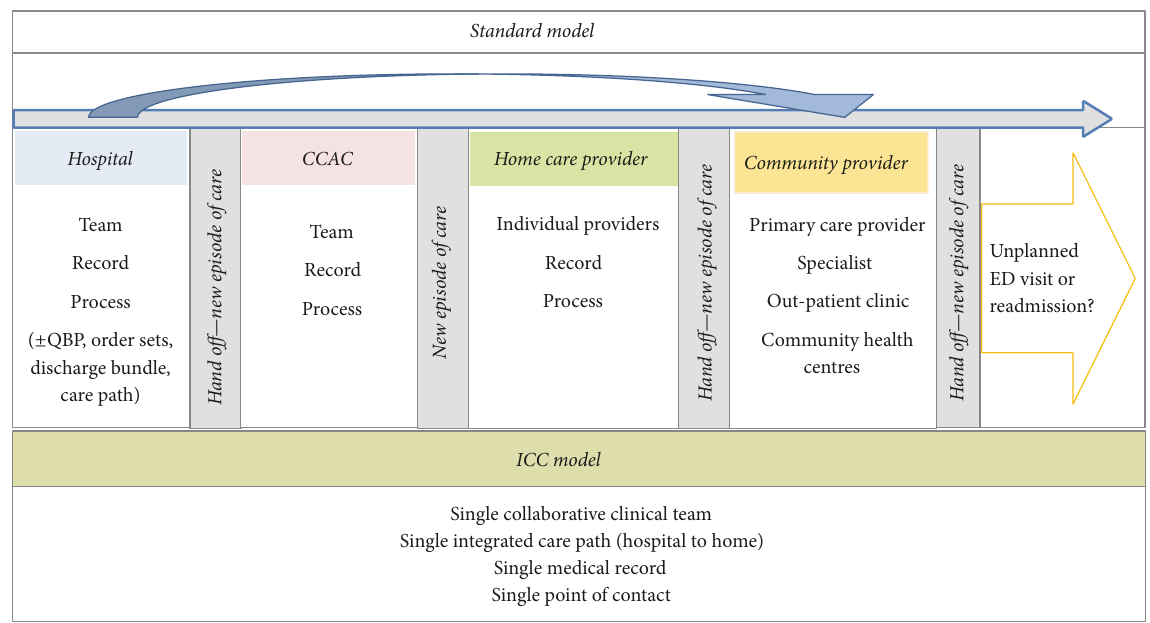
Figure 1: Standard model and ICC model of patient care. CCAC: Community Care Access Centre; ED: emergency department; ICC: integrated comprehensive care; QBP: quality-based